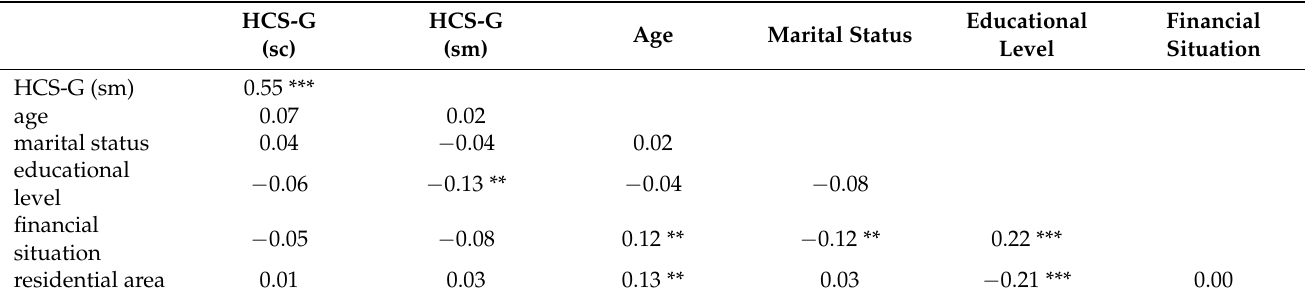
Table 4. Person correlations of health consciousness scales and sociodemographic variables.